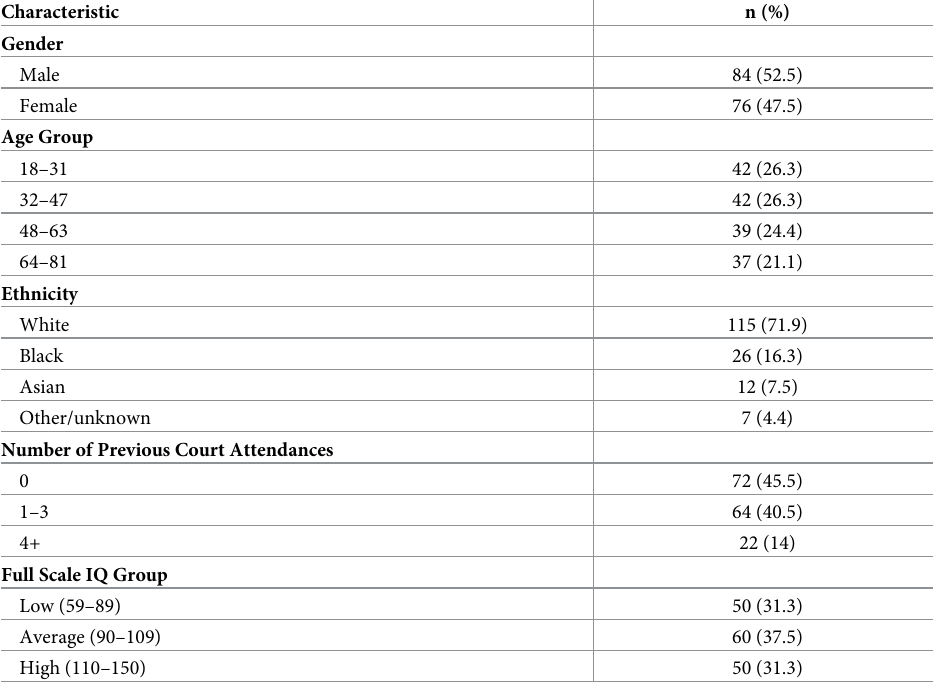
Table 1. Respondent characteristics (validation sample) n =